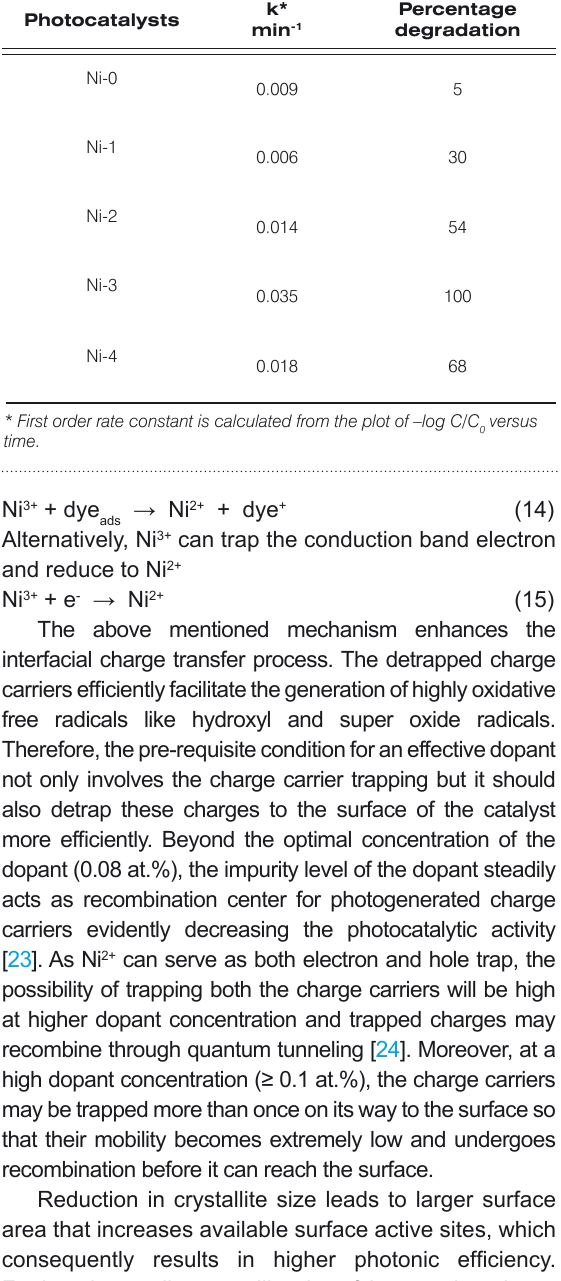
Table 2. Rate constant and percentage degradation of MO under solar light using various photocatalysts